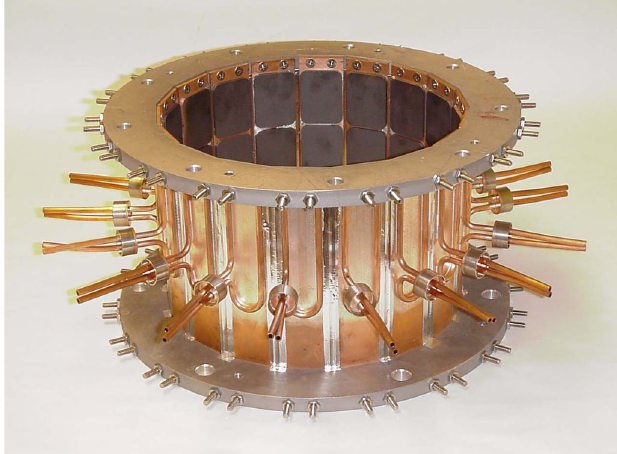
FIG. 4. (Color) HOM ferrite absorber